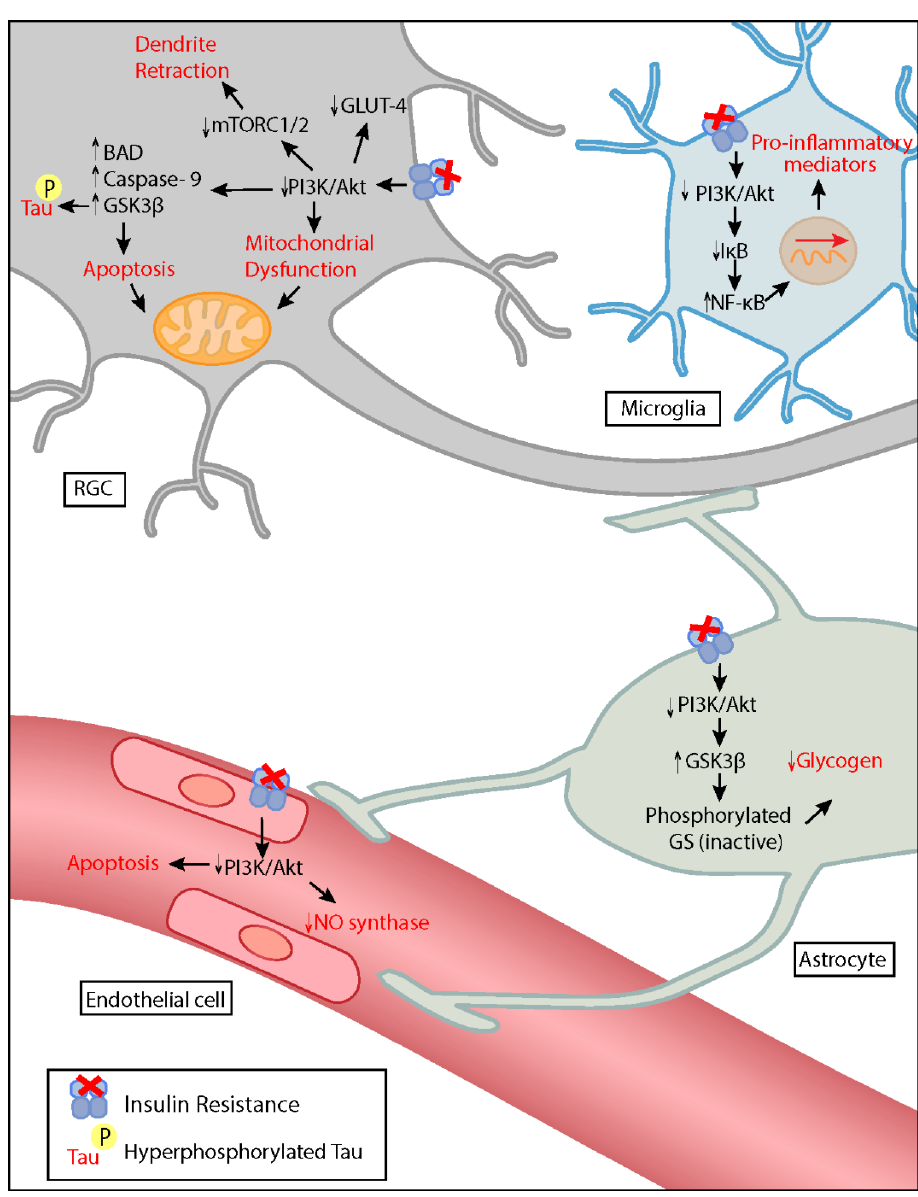
Figure 1. Possible influence of insulin resistance on the pathogenesis of glaucoma. Loss of the insulin signaling pathway reduces activation of Akt pathway. In the RGC, insulin resistance promotes dendritic retraction, mitochondrial dysfunction, tau hyperphosphorylation, and apoptosis. A decrease in insulin signaling in microglia induces the expression of pro-inflammatory mediators. It additionally contributes to vascular dysfunction by causing nitric oxide/endothelin-1 imbalance and endothelial cell apoptosis. In astrocytes, decreased insulin signaling causes depletion of glycogen stores, impairing metabolite redistribution. RGC: Retinal ganglion cell, PI3K: phosphoinositide-3 kinase, Akt: protein kinase B, mTORC: mammalian target of rapamycin complex, Bad: bcl-2 agonist of cell death, GSK3 β : glycogen synthase kinase 3- beta, GLUT-4: glucose transporter type 4, NO: nitric oxide, GS: glycogen synthase, I κ B: nuclear factor of kappa light polypeptide gene enhancer in B-cells inhibitor, NF- κ B: nuclear factor kappa-light-chain-enhancer of activated B